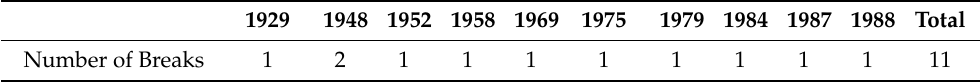
Table 2. Number of breaks within Dori time series (breaks in raw data are in 1951 and in 1966).